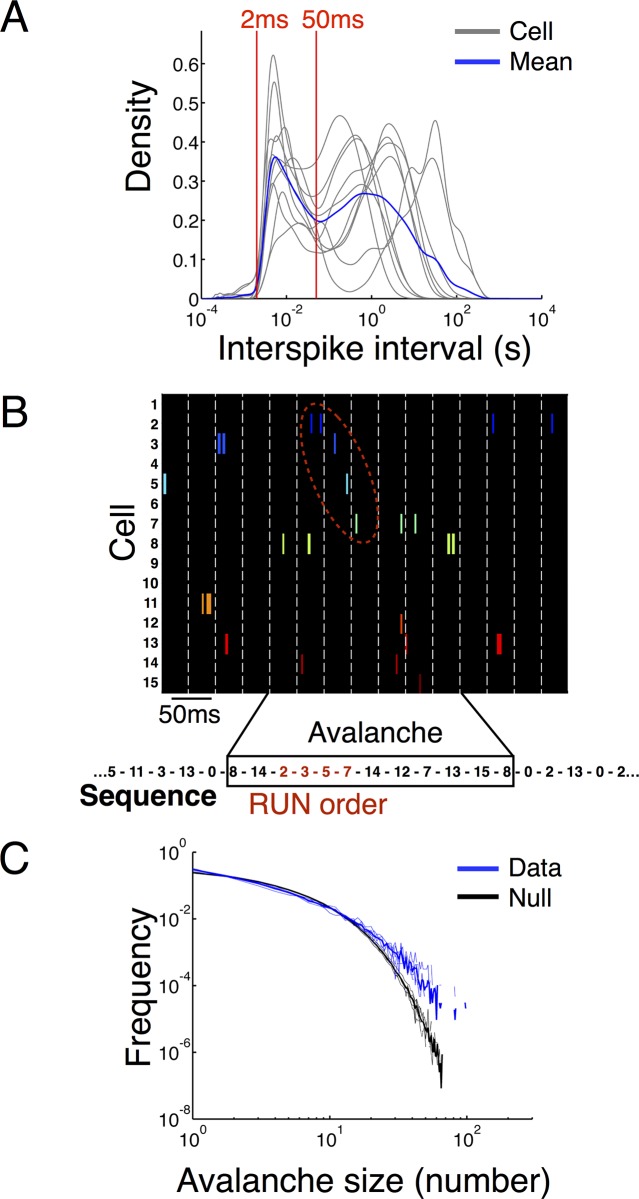
Burst structure of single units and spike avalanches.(A) The distribution of log-interspike intervals during sleep for a representative example (rat 1, session 1) is bimodal demonstrating a fast spiking regime with long gaps (bursting). The distributions for individual pyramidal cells from the session are shown in gray and the population average is in blue. Interspike intervals < 50ms (red line) indicate that two spikes belong to the same burst event. (B) Single unit bursts are correlated in time to produce ‘spike avalanches’ with many units active in a short period of time. An avalanche is defined as a sequence of time bins with spikes from some cell in the ensemble flanked by empty time bins. An example of parsing the burst activity within an avalanche into a discrete sequence is shown below. The boxed sequence is a ‘large avalanche’ that contains a subsequence that is a length-4 match to the RUN sequence (in red). (C) Rank-frequency plots of spike avalanche sizes (blue, population average over sessions in bold) compared to ISI-randomized data (black, average over sessions in bold) show that large avalanches are more common in the observed data than expected at random (all p < 10−13, Table 2).